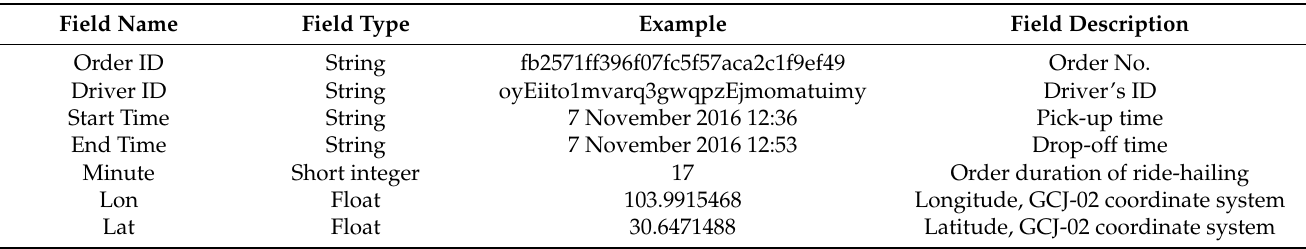
Table 2. Driving trajectory data of